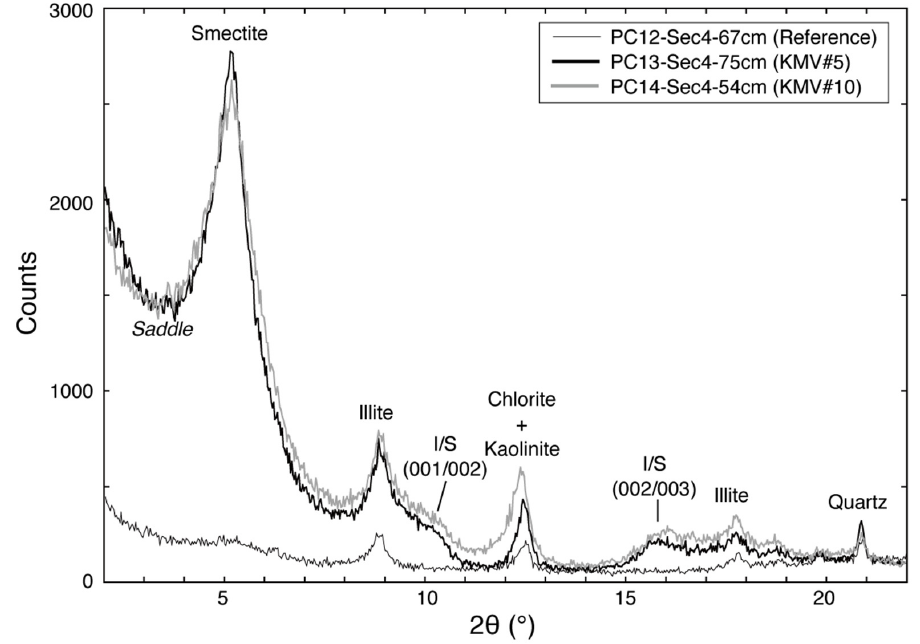
Figure 4. Representative X-ray diffractograms of clay size fractions in the ethylene-glycolated state from KMV#5 (PC13-Sec4-75 cm, 157 cmbsf), KMV#10 (PC14-Sec4-54 cm, 182 cmbsf) and reference site (PC12-Sec4-67 cm, 237 cmbsf).